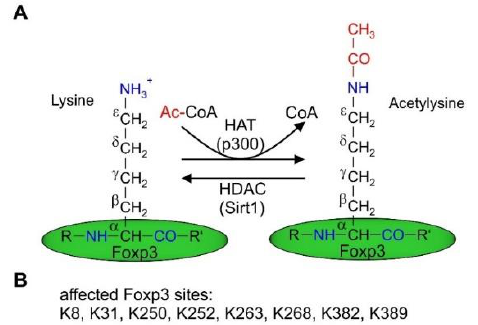
Figure 2. HAT and HDAC binding to Foxp3. ( A ) Amino groups located at the ε-CH2 group of lysines can be actetylated by histone acetylases (HATs) such as p300 or TI60 leading to acetylysine, which enhances Foxp3 stability by preventing its proteasomal degradation. Reciprocally histone deacetylases (HDACs) such as Sirt1 deacetylate lysines of Foxp3, which are acetylated at the amino-group next to the ε-C atom. Deacetylated Foxp3 is prone to proteasomal degradation [122]. ( B ) Lysines of Foxp3, which have been identified as targets for acetylation [123–126].